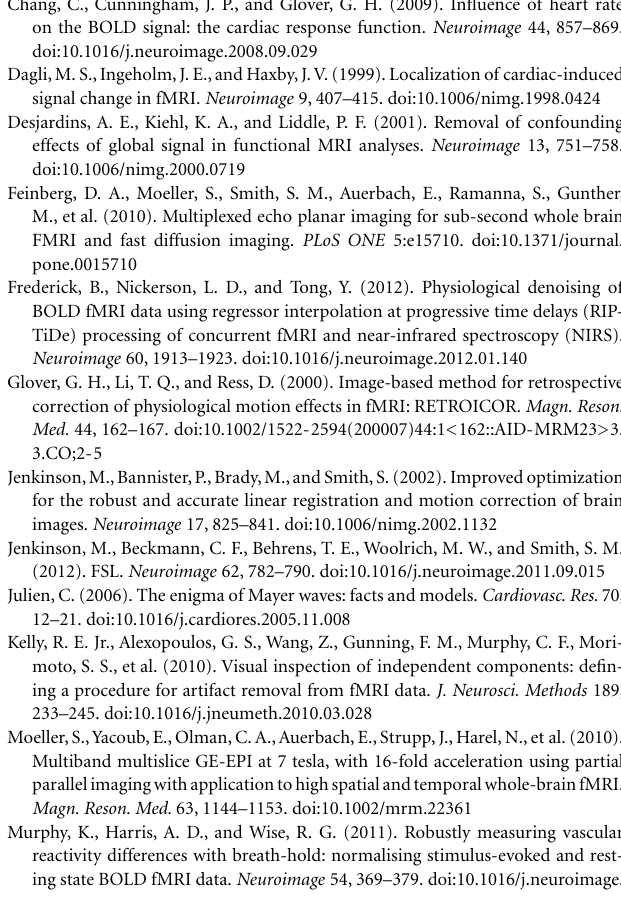
Figure S1 | Power spectra of representative BOLD signals from the rest eight subjects .These voxels are all from the bottom slices of each subject. Three frequency bands corresponding to LFOs (in black), respiration (blue), and cardiac pulsation (red) are marked in each